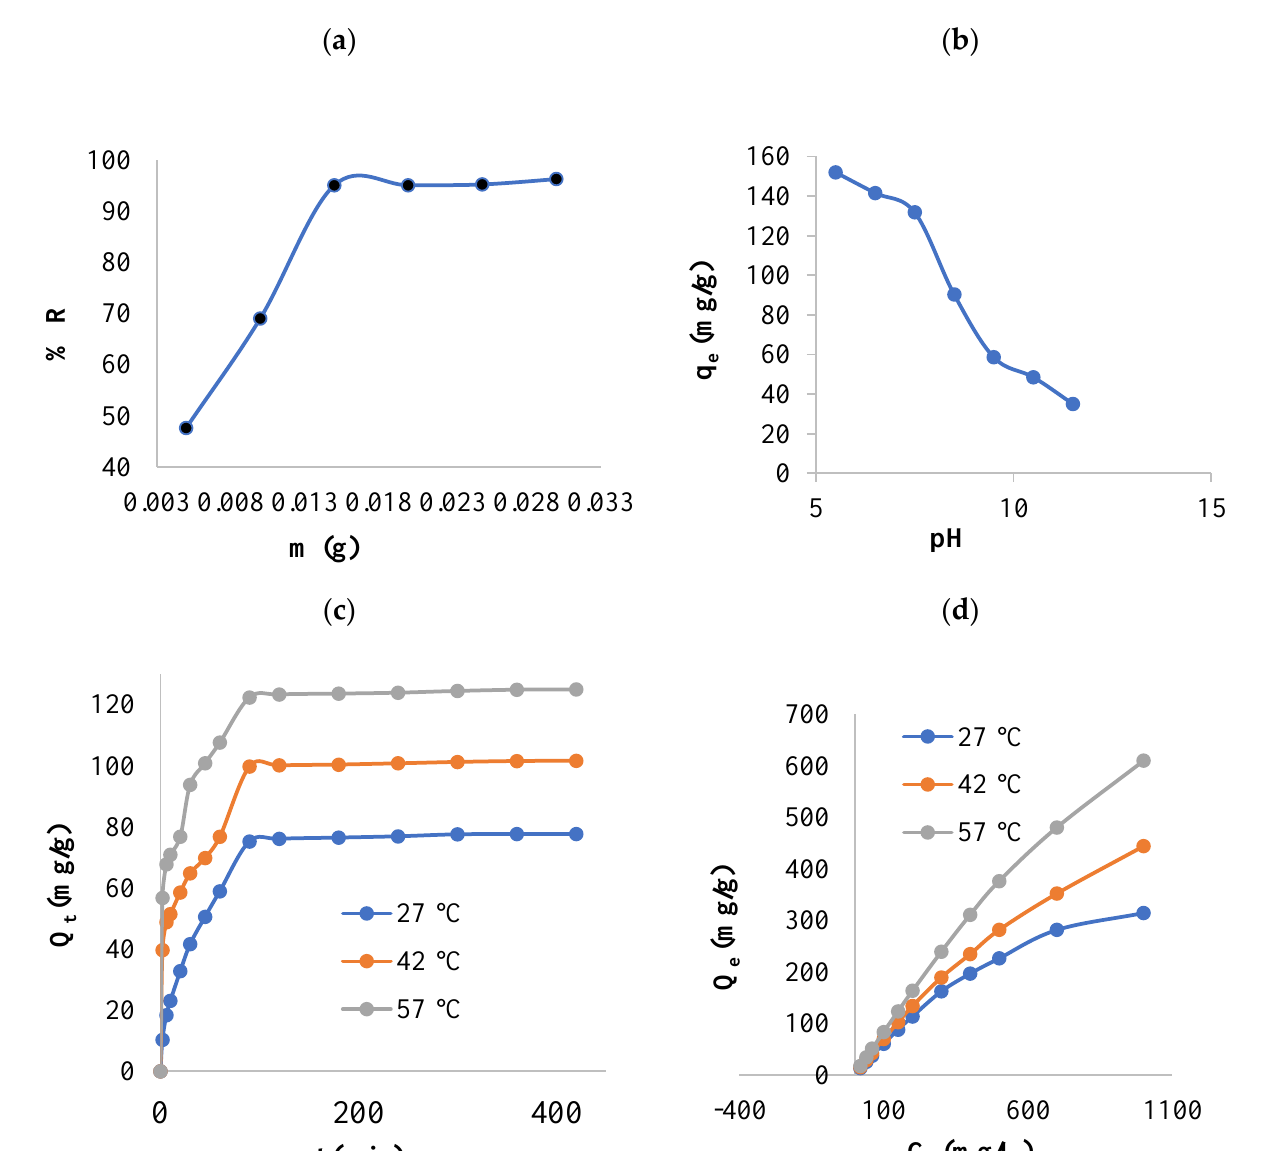
Figure 5. ( a ) Impact of the adsorbent dose; ( b ) impact of pH; ( c ) impact of agitation time; ( d ) impact of Congo red concentration.